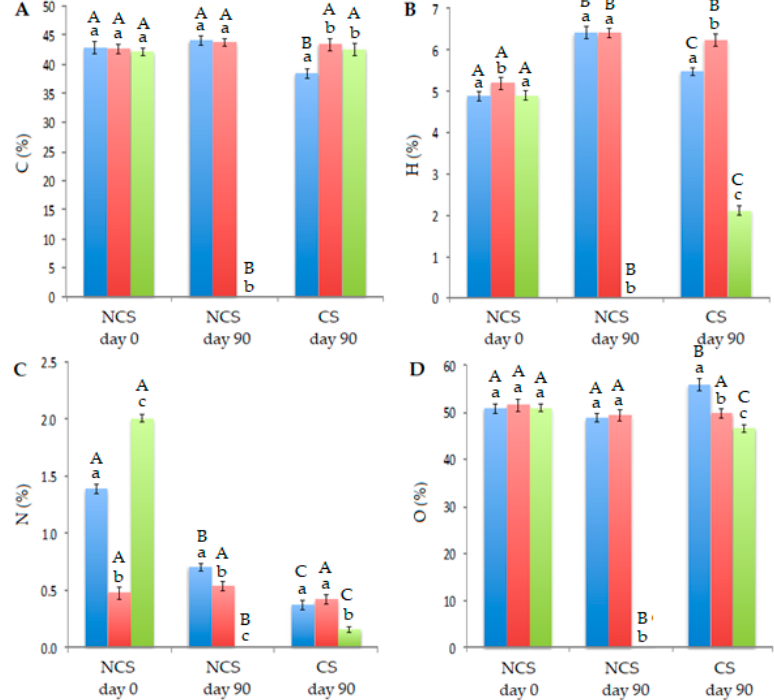
Figure 2. Percentages of carbon ( A ), hydrogen ( B ), nitrogen ( C ) and oxygen ( D ) in roots (blue bars), stems (red bars) and leaves (green bars) of plants grown in NCS and CS at days 0 and 90. For each element, different lowercase letters in the bars within the same soil indicate significant differences in roots, stems and leaves, while different uppercase letters in roots, stems or leaves indicate significant differences among soils/days, both according to Duncan’s multiple range test ( p ≤ 0.05).